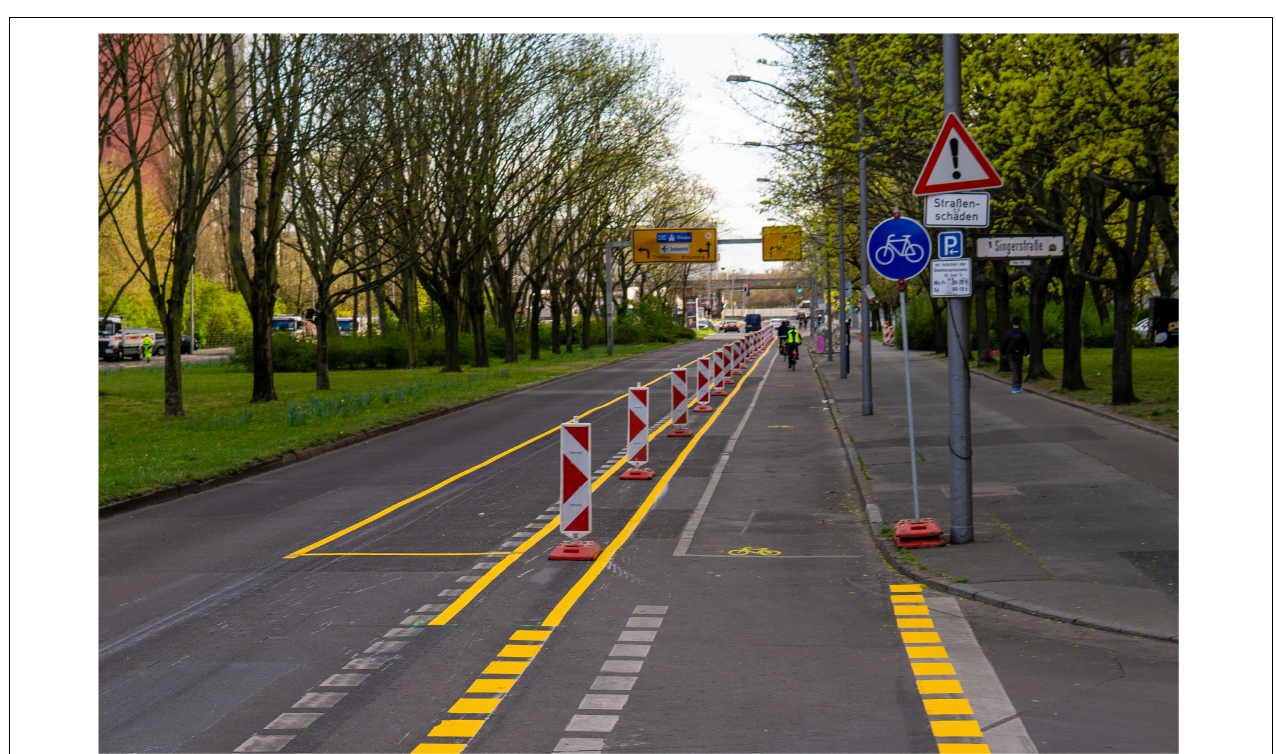
FIGURE 1 | A “pop-up bike lane” in Berlin-Kreuzberg, built at the beginning of the corona crisis in 2020 (source: Peter Broytman,